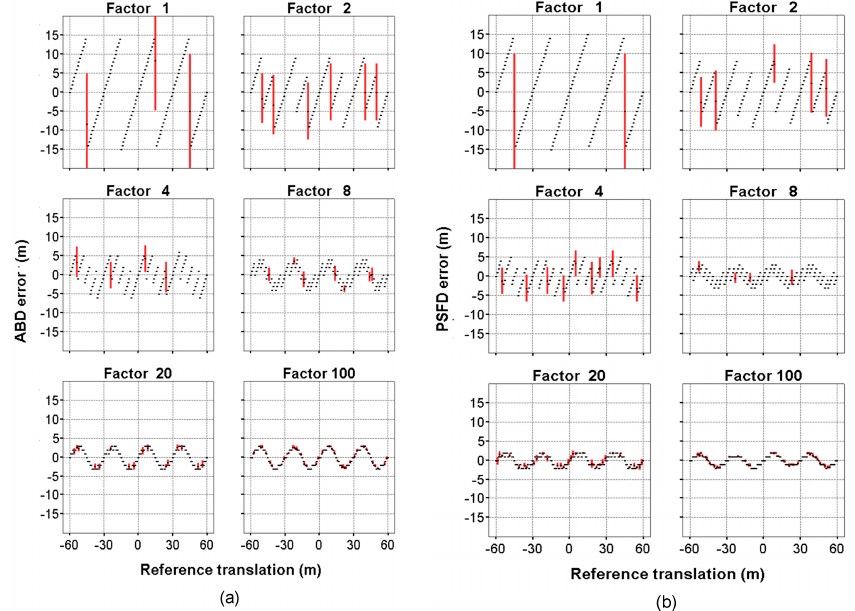
Figure 5. Every image with known translation (T IN ) and downsampling method: ( a ) for ABD set; and ( b ) for PSFD set, was matched with the reference ( T = 0) using different upsampling factors. Considering three bands, nine CC results are available ( T OUT ). The mean value of the nine T OUTs is shown as black dots, and the standard deviation is represented by the red vertical bar. The nine solutions ( T OUTs ) coincide and there are deviation bars only for some specific cases, decreasing as the applied factor increases.